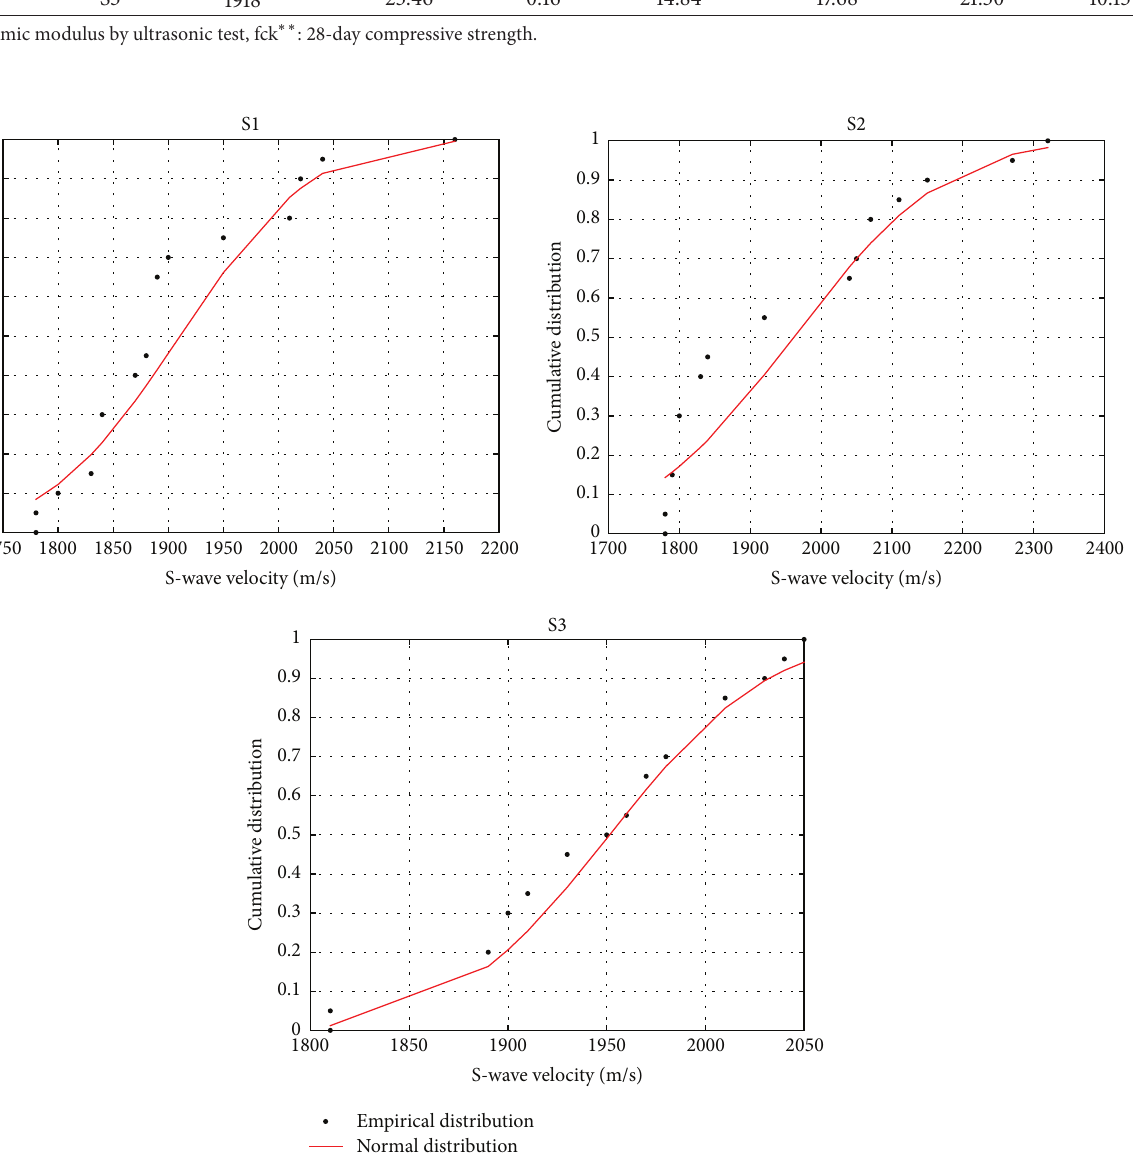
Figure 18: Cumulative normal distribution function of S-wave